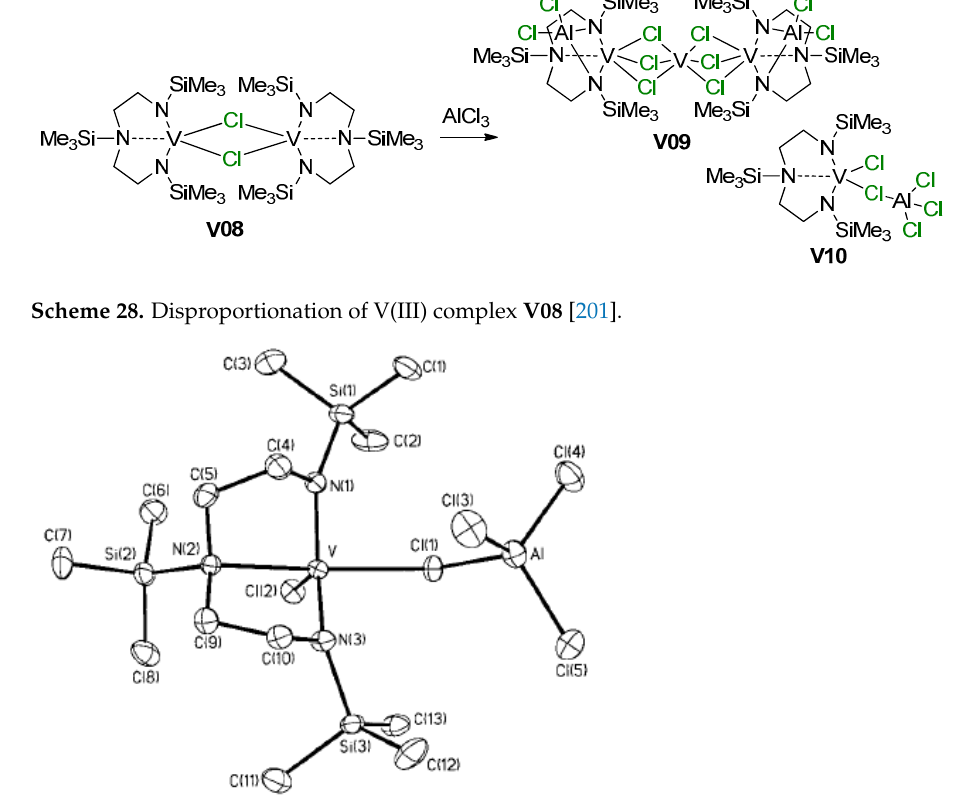
Figure 24. ORTEP plot of V10 . Thermal ellipsoids are drawn at the 30% probability level. Reprinted with permission from [201]. Copyright (2002) American Chemical Society.